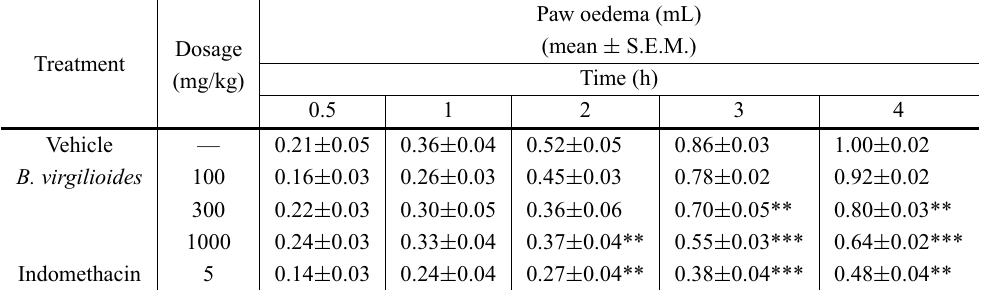
Paw oedema (mL) (mean ± S.E.M.)